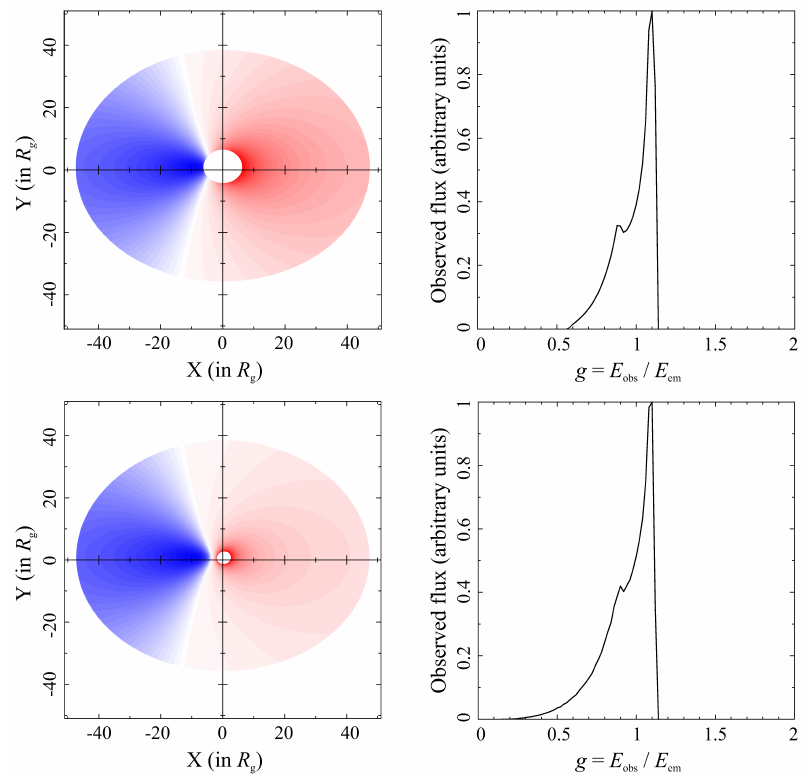
Fig. 1. Illustrations of an accretion disk (left panels) and the corresponding Fe K (cid:11) line profiles (right panels) for the disk inclination i = 40 ◦ in the Kerr metric for the angular momenta a = 0.1 (upper panels) and a = 0.998 (lower